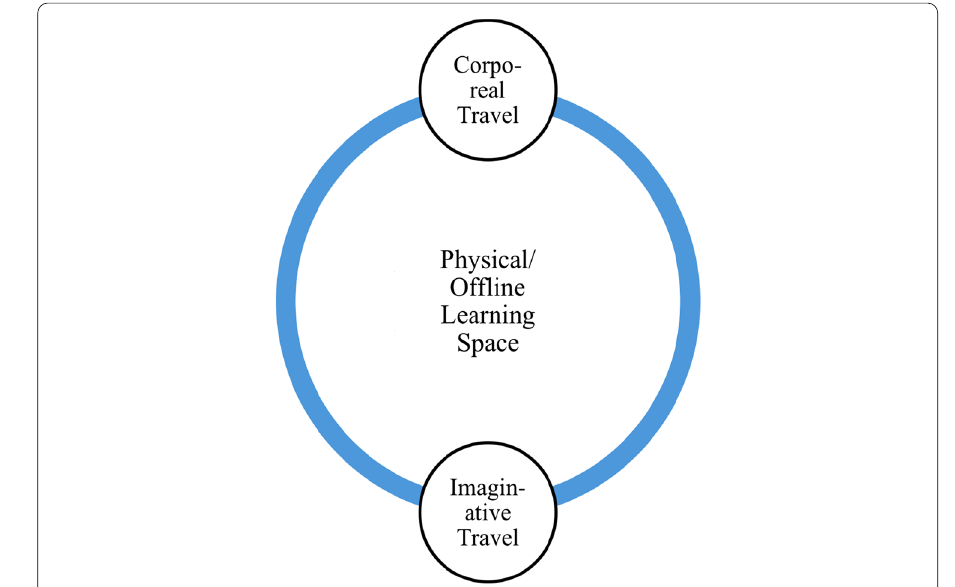
Fig. 2 Mobility in physical learning space